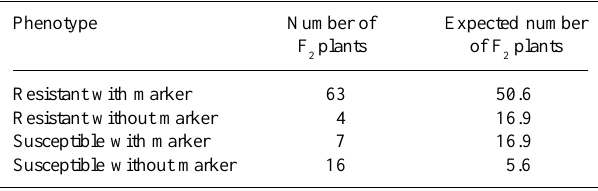
Table II - Relationship between the F bean phenotypes associated with 2 resistance to Colletotrichum lindemuthianum and the occurrence of the marker generated by primer OPC08.